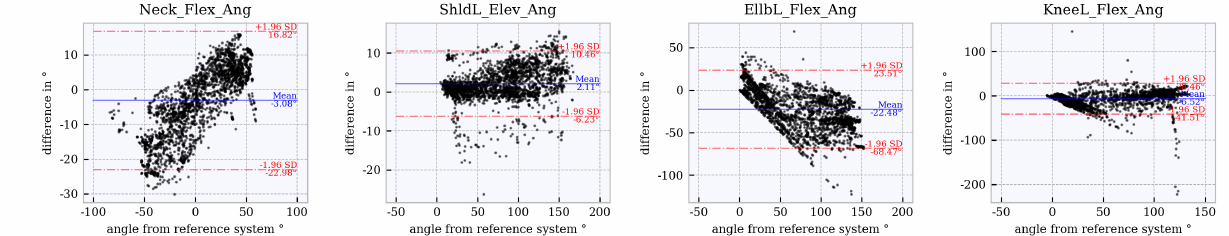
Figure 18. Bland–Altman plot for tracker configuration 9 from WIDAAN ; x does not show the average of both systems but the joint angles of the reference system,